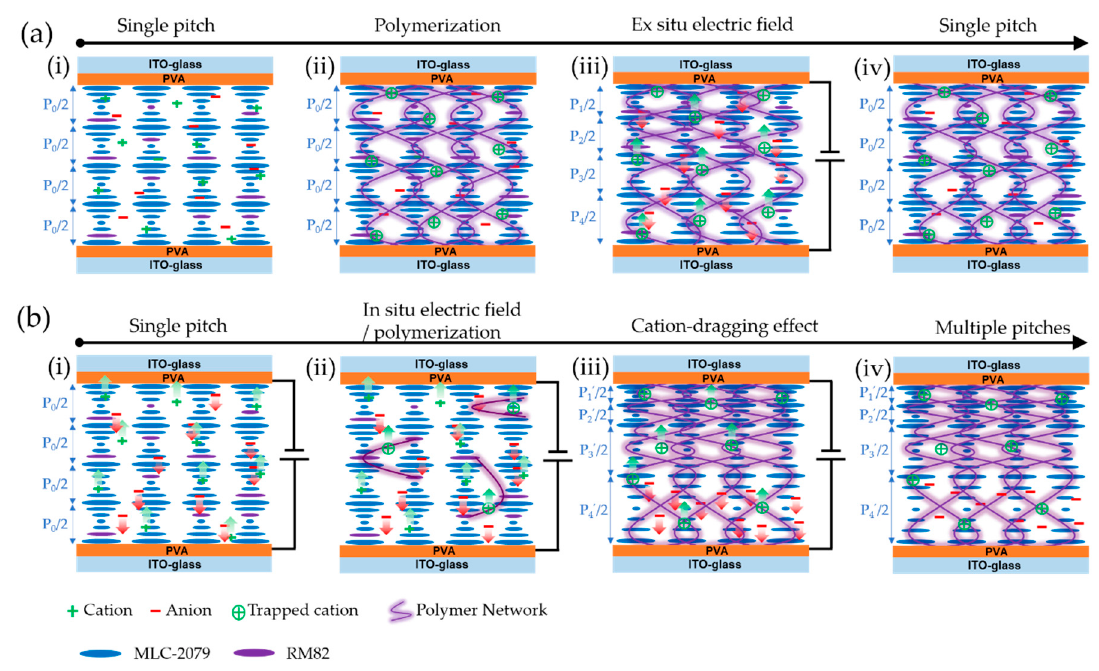
Figure 2. Schematic illustration of pitch length modulation in CLC cell under ( a ) ex situ electric field and ( b ) in situ electric field. Legend: ITO, indium tin oxide; PVA, polyvinyl alcohol.